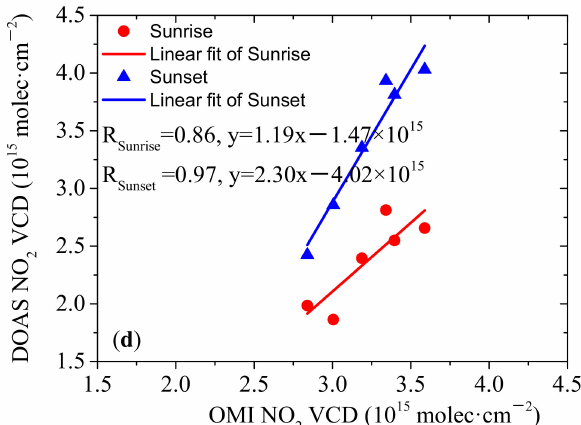
Figure 10. Temporal variation of the NO 2 VCDs at 90 ◦ SZA as well as the correlation between the ground-based zenith DOAS and OMI satellite observations. ( a ) Time series of the daily NO 2 VCDs; and the ratios of the NO 2 VCDs at sunset to those at sunrise (shown as grey stars). ( b ) Correlation of the daily NO 2 VCDs between the DOAS measurement at sunrise and sunset and the OMI satellite observations; the red and blue lines indicate the linear fits between both data sets, respectively. ( c ) The variation of the monthly NO 2 VCDs calculated from the daily results; the error bars represent the standard deviations of the monthly mean NO 2 VCDs. ( d ) Same as ( b ), but for the monthly averaged NO 2 VCDs. The black squares denote the OMI satellite product (OMNO2d). The red, blue, and pink symbols denote the NO 2 VCDs measured by the ground-based DOAS at sunrise and sunset as well as the average of sunrise and sunset. R and the formula in the figure indicate the correlation coefficient and the equation of the linear regression,